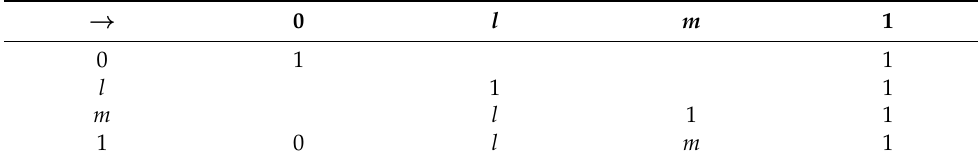
Table 12. The partial operation →